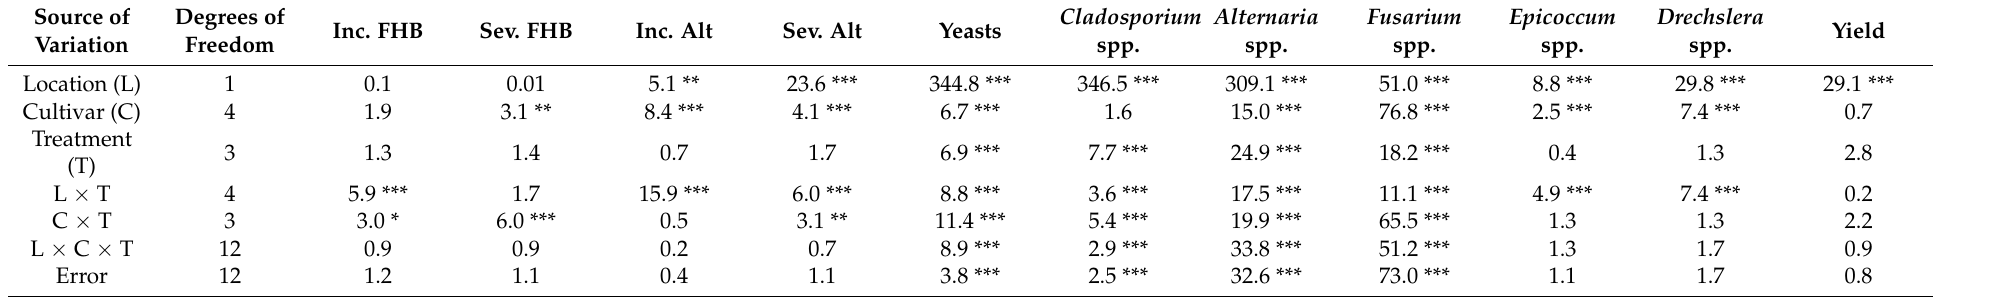
Table 4. The F-values for experiment treatments and interactions obtained in the three-way